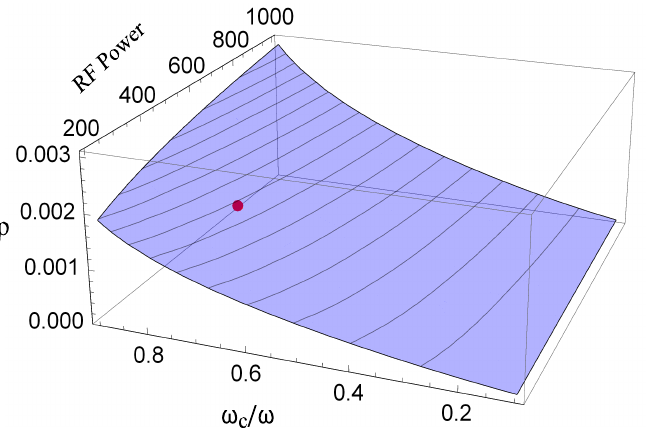
Figure 10. Pierce parameter vs. RF power. The dot indicates the working point of ref.